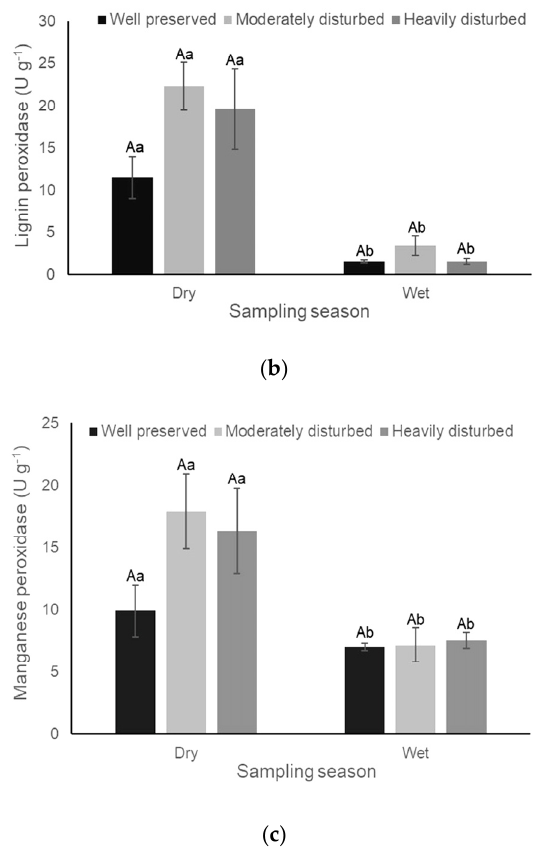
Figure 1. Enzyme activities in litter samples from three forest sites with increasing levels of disturbance in central Mexico by sampling date. Enzyme activities for laccase ( a ), lignin peroxidase ( b ), and manganese peroxidase ( c ) are shown by site and season. Capital letters denote significant differences between sites; lowercase letters denote significant differences between sampling dates ( p ≤ 0.05).